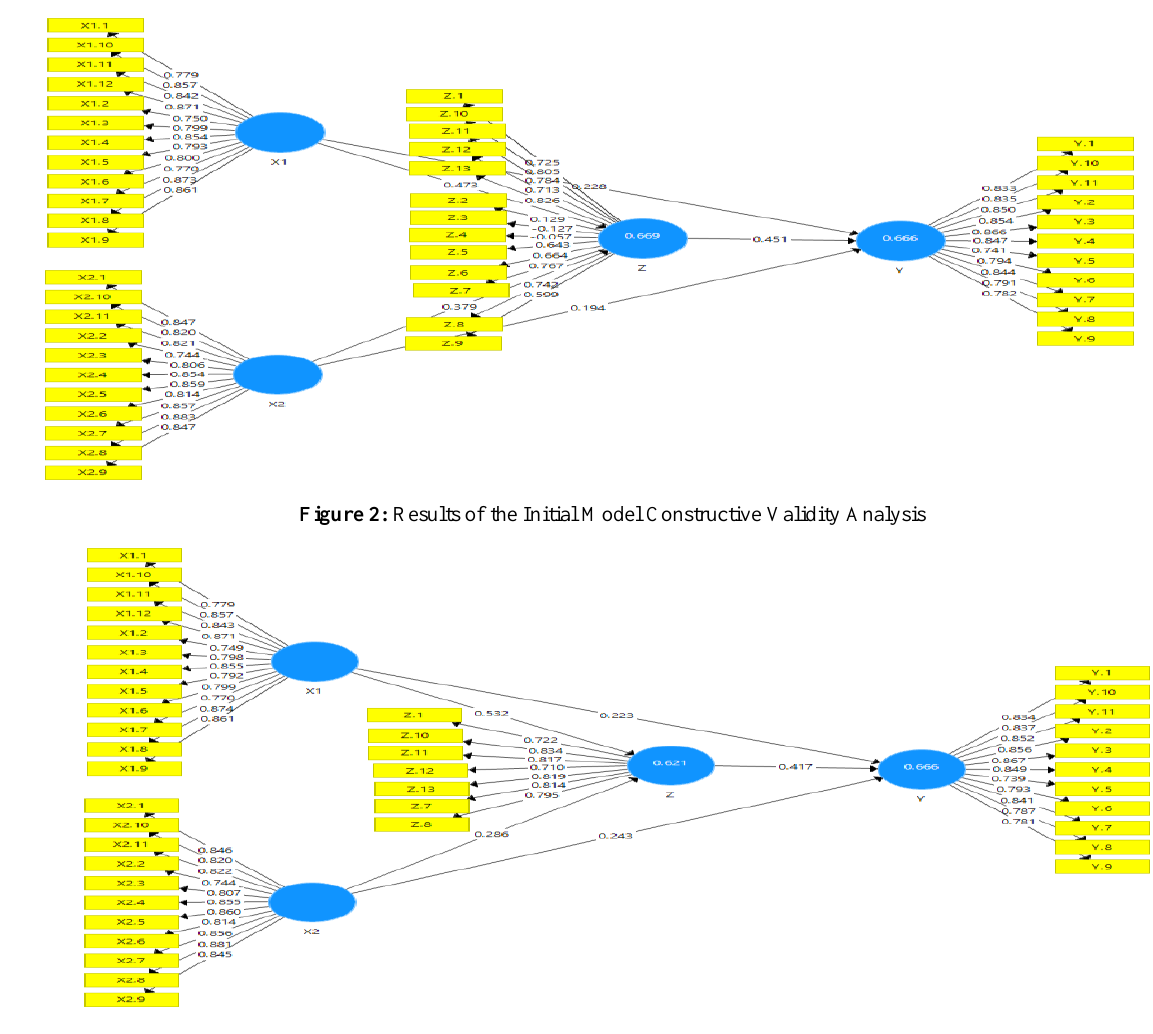
Figure 3: Results of Convergent Validity After Repair Table 2: Indicator Test Outer